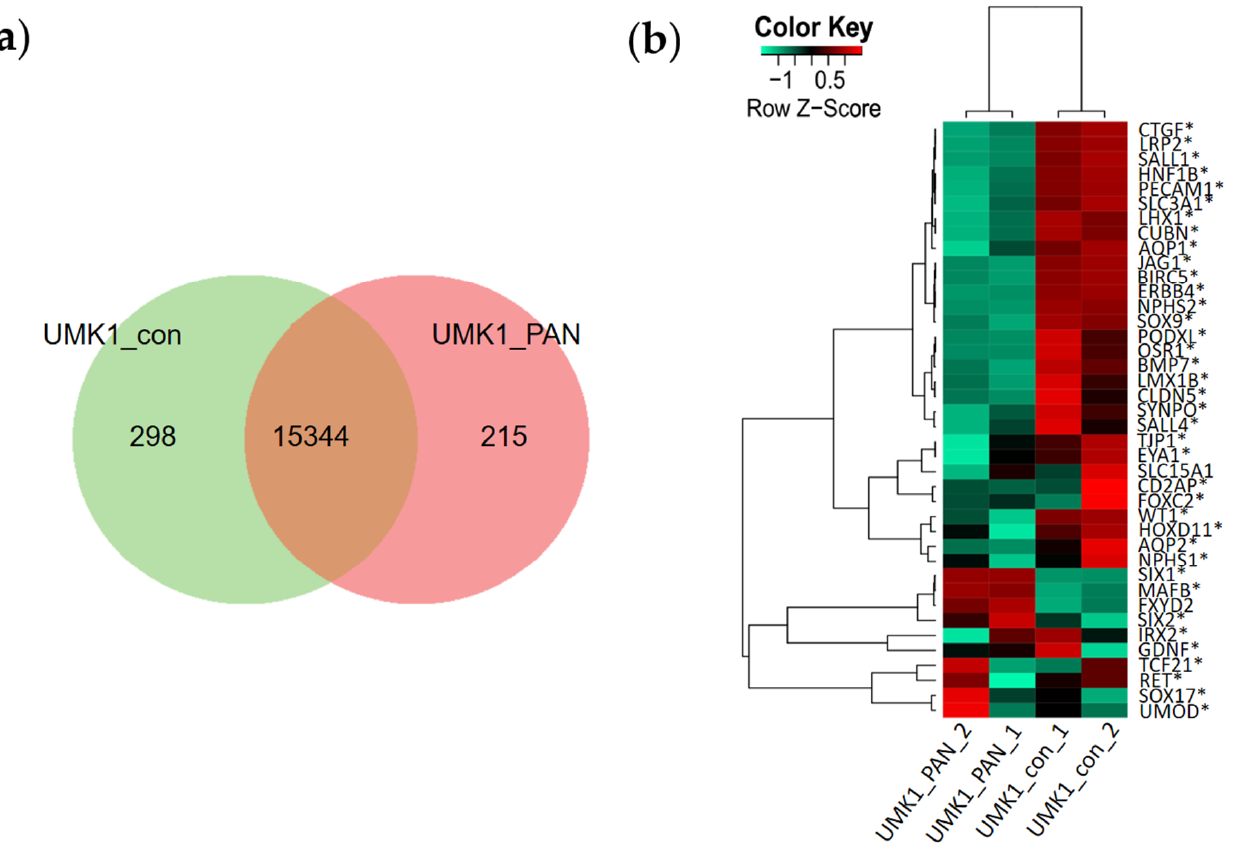
Figure 4. Transcriptome analysis of UMK1 with and without PAN treatment. ( a ) The common gene-sets between UMK1_con and UMK1_PAN consisted of 15344 genes. Exclusively expressed in UMK1_con and UMK1_PAN are 298 and 215 genes, respectively. ( b ) Expression of kidney-associated genes in UMK1_con and UMK1_PAN is displayed in a Pearson heatmap.